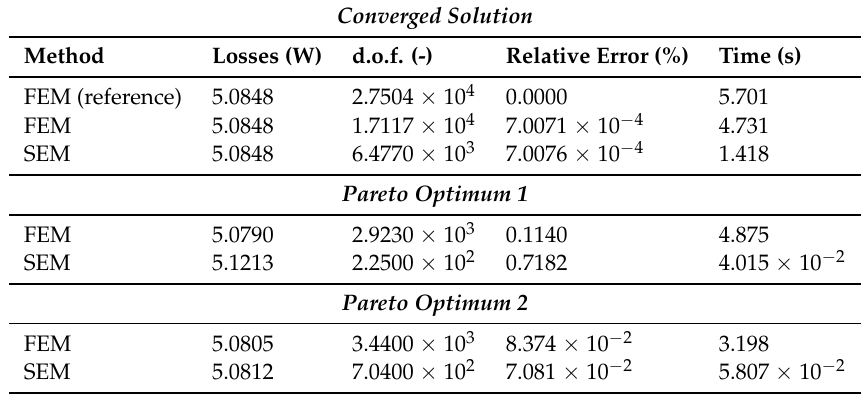
Table 3. Converged solution, including the reference and Pareto optima ( w 1 = w 2 = 0.5 ) for both methods.